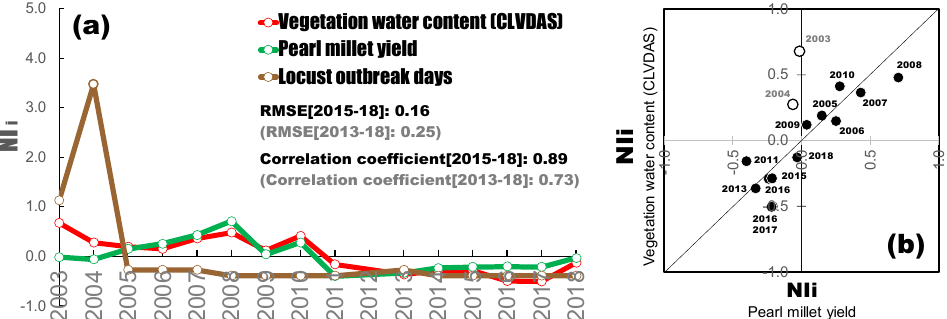
Figure 7. ( a ) Comparison of the normalized index ( NI i ) for the vegetation water content (CLVDAS) (blue line), pearl millet yield (red line), and number of locust outbreak days (brown line), and ( b ) scatterplot between the NI i for vegetation water content and the NI i for pearl millet yield of the Sahel-inland region. The number of locust outbreak days was calculated as follows. The number of days ( x i ) in each year (2003–2018) were counted when more than 10 locust plagues occurred in the Sahel-inland region according to the FAO Locust watch. Then, the average ( µ ) and standard deviation ( σ ) were calculated using these numbers ( x i ) for each year. Using these values of x i , µ , and σ , the normalized index ( NI i ) based on the z-score theory was calculated. In this study, we assessed agricultural drought for the period 2005–2018, excluding 2003–2004. For this period, the RMSE between the NI i for pearl millet yield and the NI i for vegetation water content was 0.16 and the correlation coefficient was 0.89, indicating strong